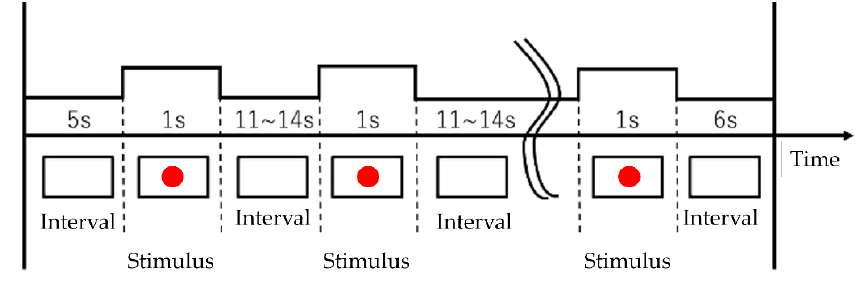
Figure 7. Stimulus interval and presentation.